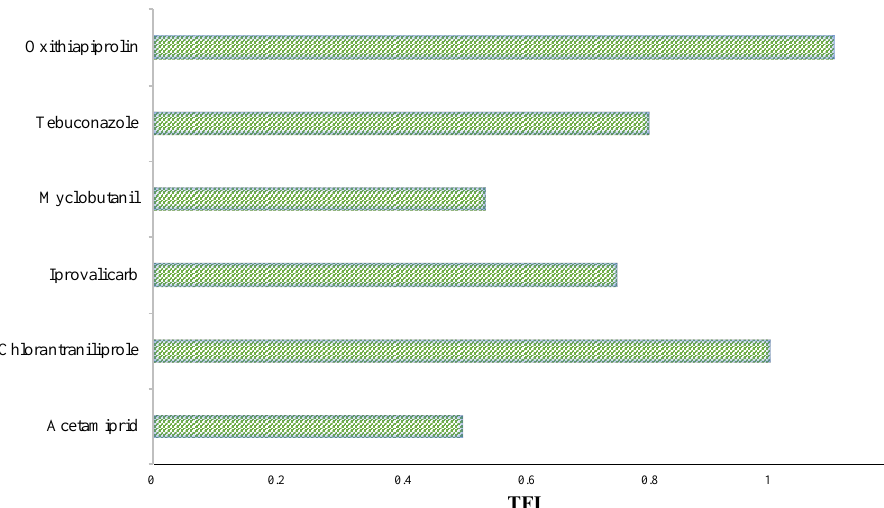
Figure 3. The distribution of the Treatment Frequency Index (TFI) for the studied arable cropping systems.